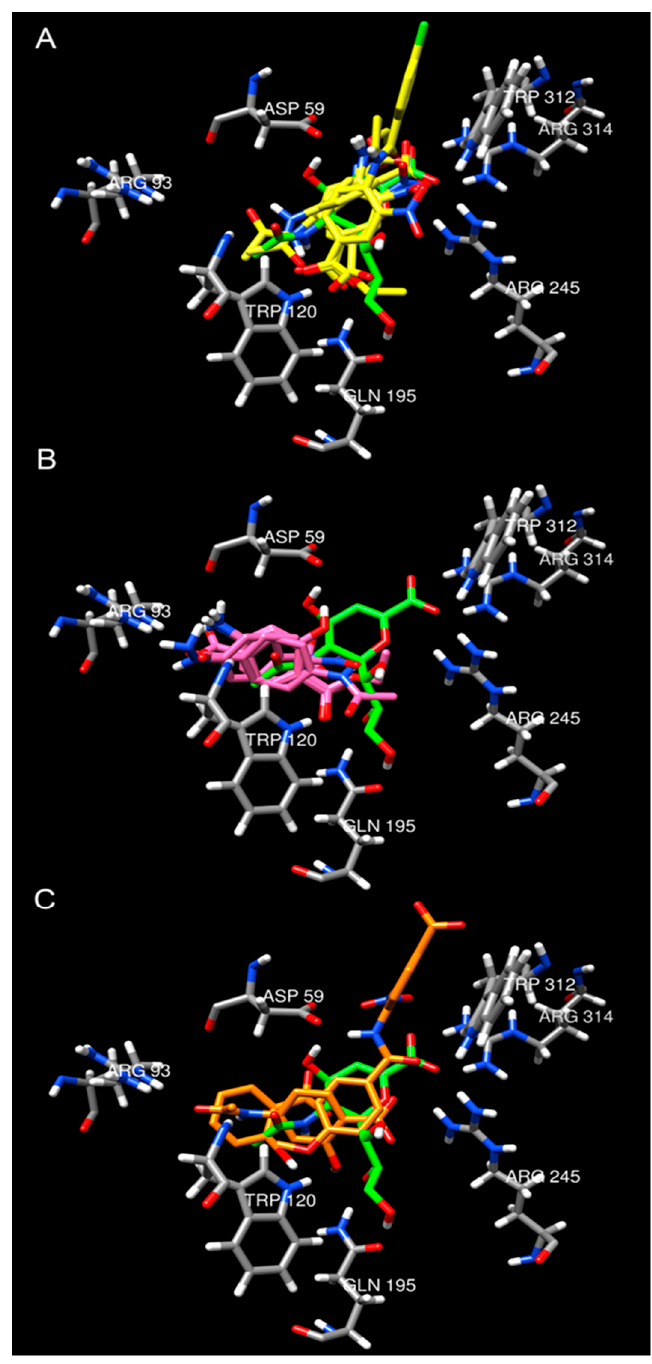
Figure 5. Best-scored conformations obtained for compounds 10 – 24 and their comparison with the ligand DANA in the crystal structure of TcTS (green). Compounds with binding modes classified as A are shown in pannel ( A ) as yellow structures; those classified as B are shown in pannel ( B ) as pink structures; and those classified as C are shown in pannel ( C ) as orange structures.